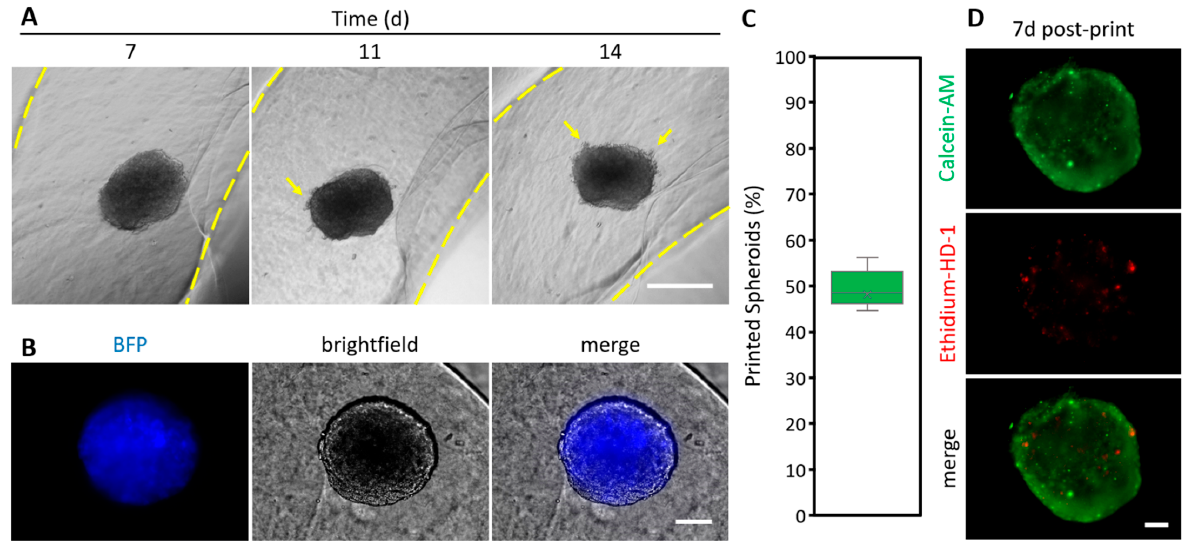
Figure 8. Printed spheroids in CANAHA bioink. ( A ) Time course of A549-BFP spheroid culture (yellow arrows indicate outgrowth of cells; space in yellow dashed lines indicates printed gel), scale bar 1000 µm. ( B ) Fluorescence microscopy image of A549-BFP spheroid 7 d after printing, scale bar 100 µm. ( C ) Rate of printed spheroids, n = 7 prints with 780 spheroids in total. ( D ) Calcein-AM and ethidium-HD-1 staining (live and dead assay) of bioprinted A549 spheroids 7 d after printing, scale bar 100 µm.